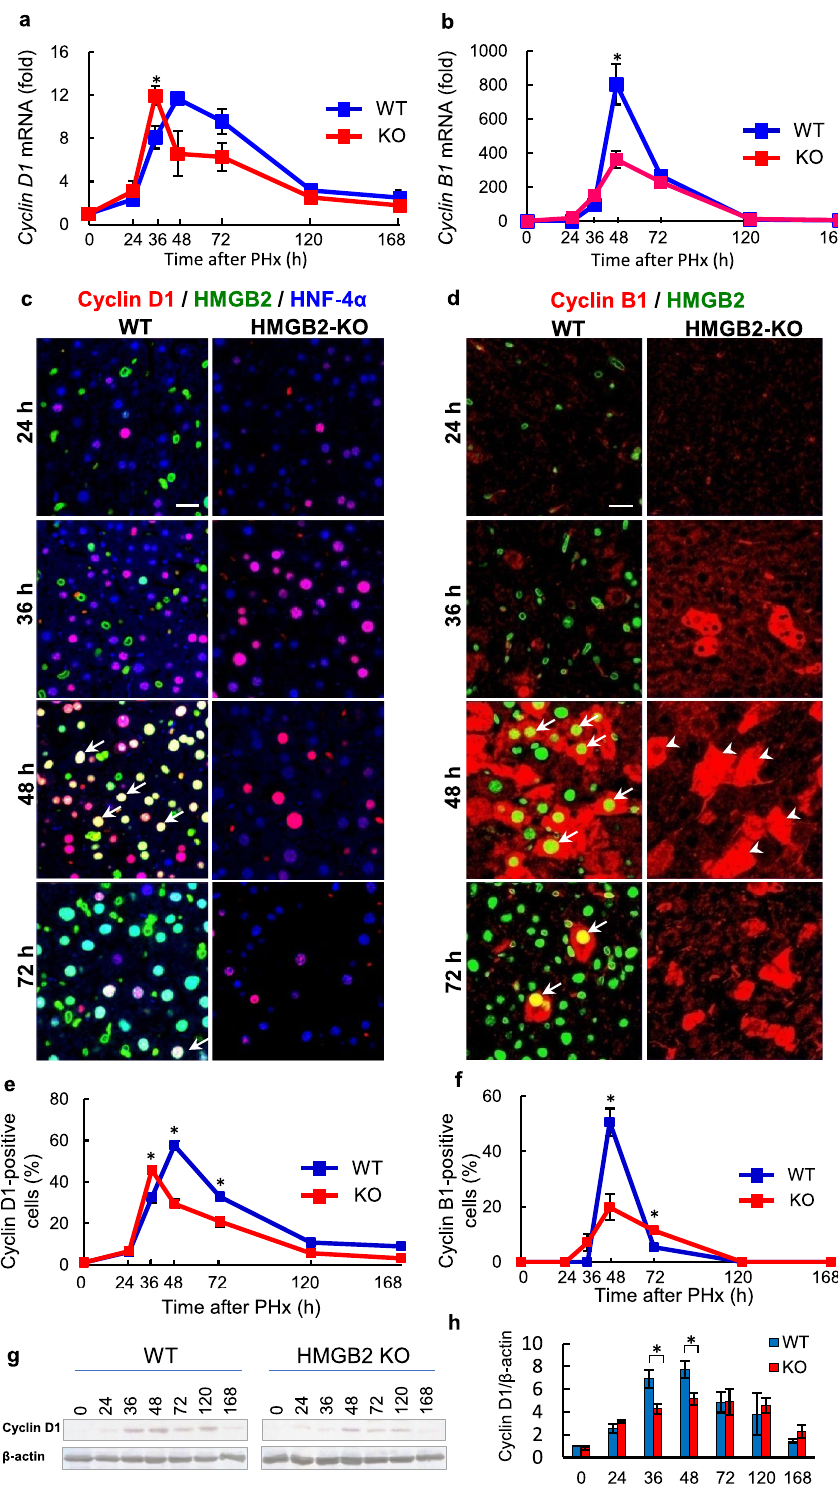
Figure 4. Co-localization of HMGB2 and cyclin D1, cyclin B1 in mouse liver during regeneration. qPCR analysis of cyclin D1 ( a ) and cyclin B1 ( b ) mRNA in WT and HMGB2-KO mouse livers. ( c ) Immunofluorescence for cyclin D1 (red), HMGB2 (green) and HNF-4α (blue) in WT and HMGB2-KO mouse livers after PHx. ( d ) Double immunofluorescence for cyclin B1 (red) and HMGB2 (green) in WT and HMGB2-KO mouse livers. Arrows indicate HMGB2- and cyclin D1- or cyclin B1-positive hepatocytes. Arrowheads indicate cyclin B1-positive hepatocytes in HMGB2-KO mouse liver at 48 h. Scale bar 20 μm. The number of cyclin D1- ( e ) and cyclin B1-positive ( f ) hepatocytes was counted at each time-point after PHx. Data represent the mean ± SEM from 5–6 mice per group. ( g ) Western blotting of cyclin D1 in WT and HMGB2-KO mouse livers after PHx. ( h ) Densitometry analysis of cyclin D1 expression. Data represent the mean ± SEM from 3 mice per group. Asterisks indicate statistically significant differences (* p <